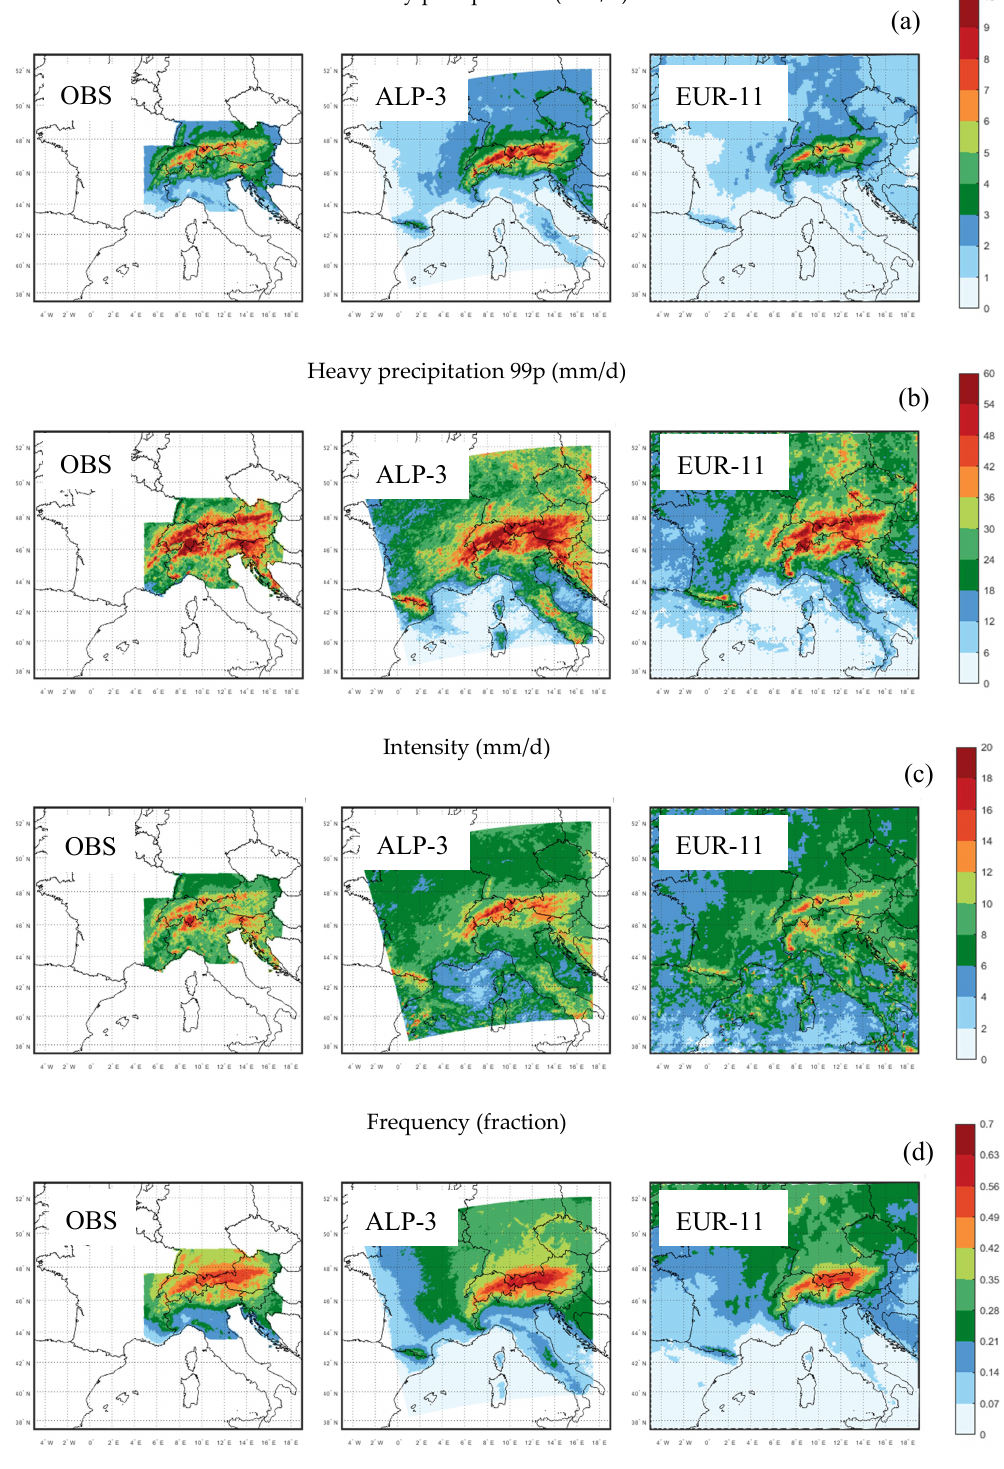
Figure 2. Spatial distribution at daily scale of mean precipitation ( a ), heavy precipitation 99p ( b ), intensity, ( c ) and frequency ( d ) for observations (OBS), ALP-3, and EUR-11 (evaluation experiments) over summer (June–July–August, JJA) 2000–2009. For OBS, gridded dataset EURO4M-APGD over summer (JJA) 2000–2008 is